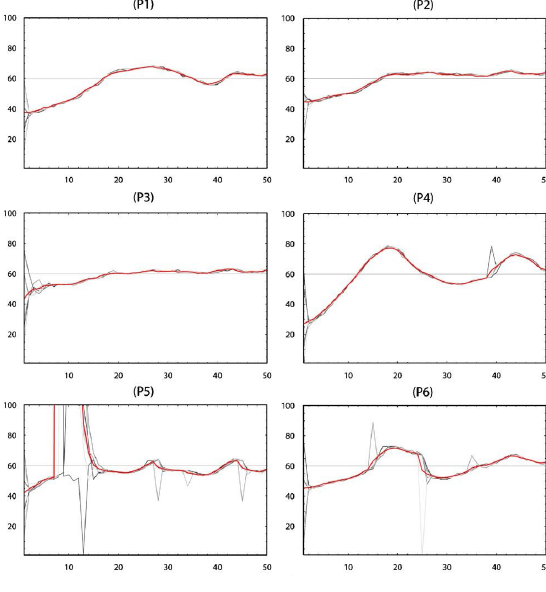
Figure 5: Experiments by Heemeijer et al. (2009) with strategic substitutes, p = − 20 iments with strategic complements p = 20